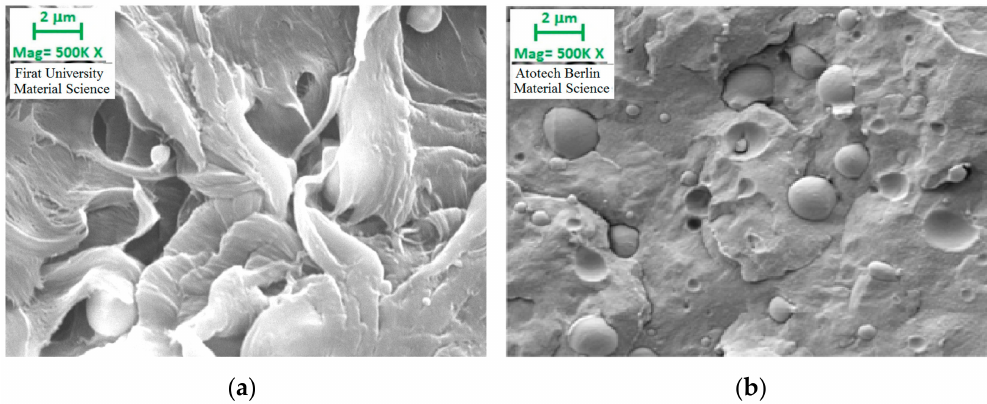
Figure 13. Electron microscope images of 10% filler reinforced polypropylene specimens with ( a ) and without ( b ) (Kısmet, 2012) gamma